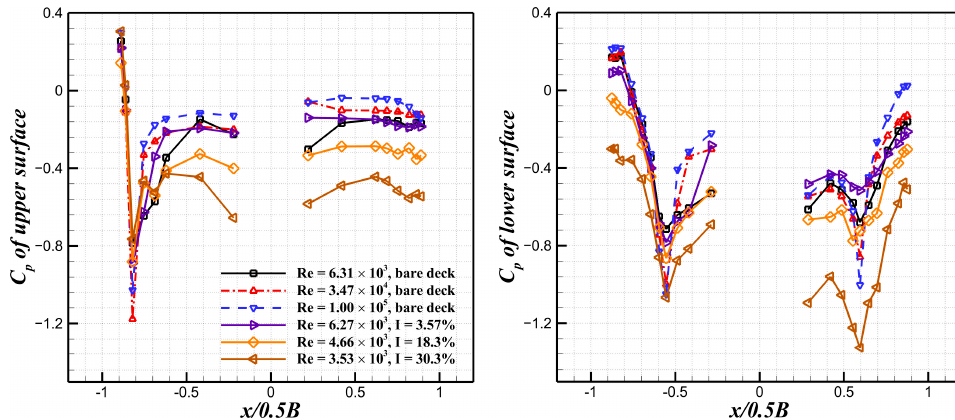
Figure 10. Comparisons of the time-averaged surface pressure distribution of the twin-box girder with body-height grid interference and bare deck.